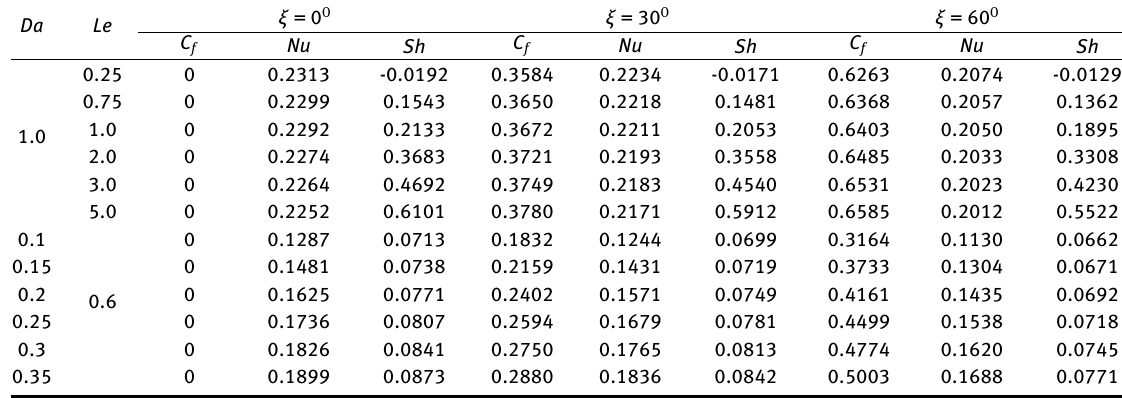
Table 4: Values of C f , Nu and Sh for different Da , Le and ξ ( β = 1.0, Nb = Nt = 0.2, Nt = 0.1, Λ = 1.0, M = 0.5, Pr = 0.71)